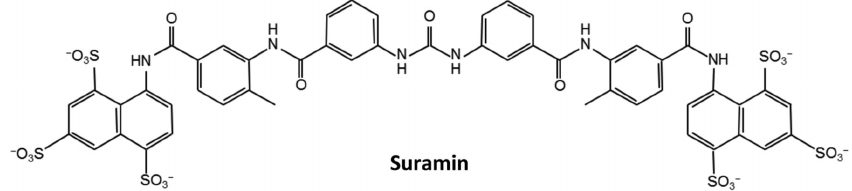
Figure 1. The chemical structure of